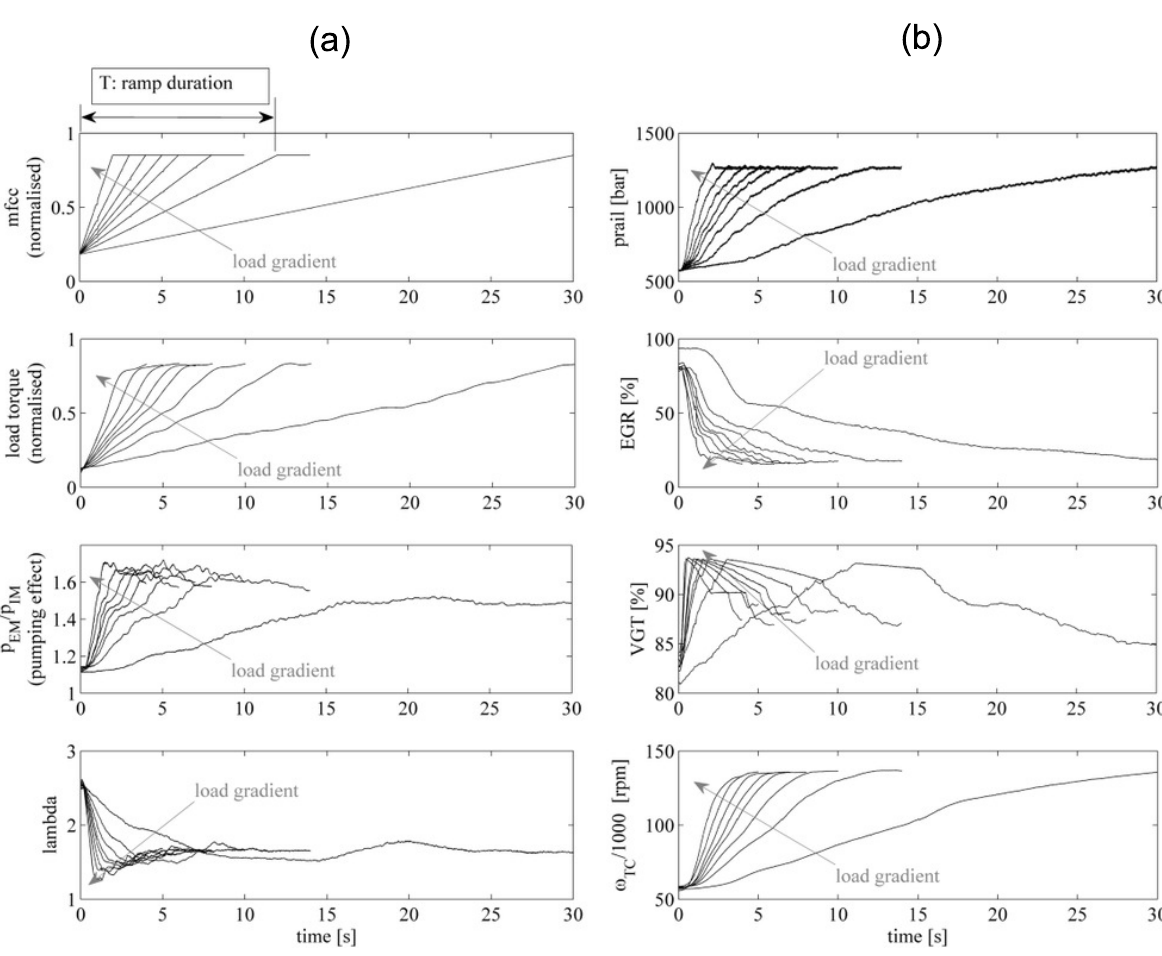
Figure 2. Ramp profiles performed at 1950